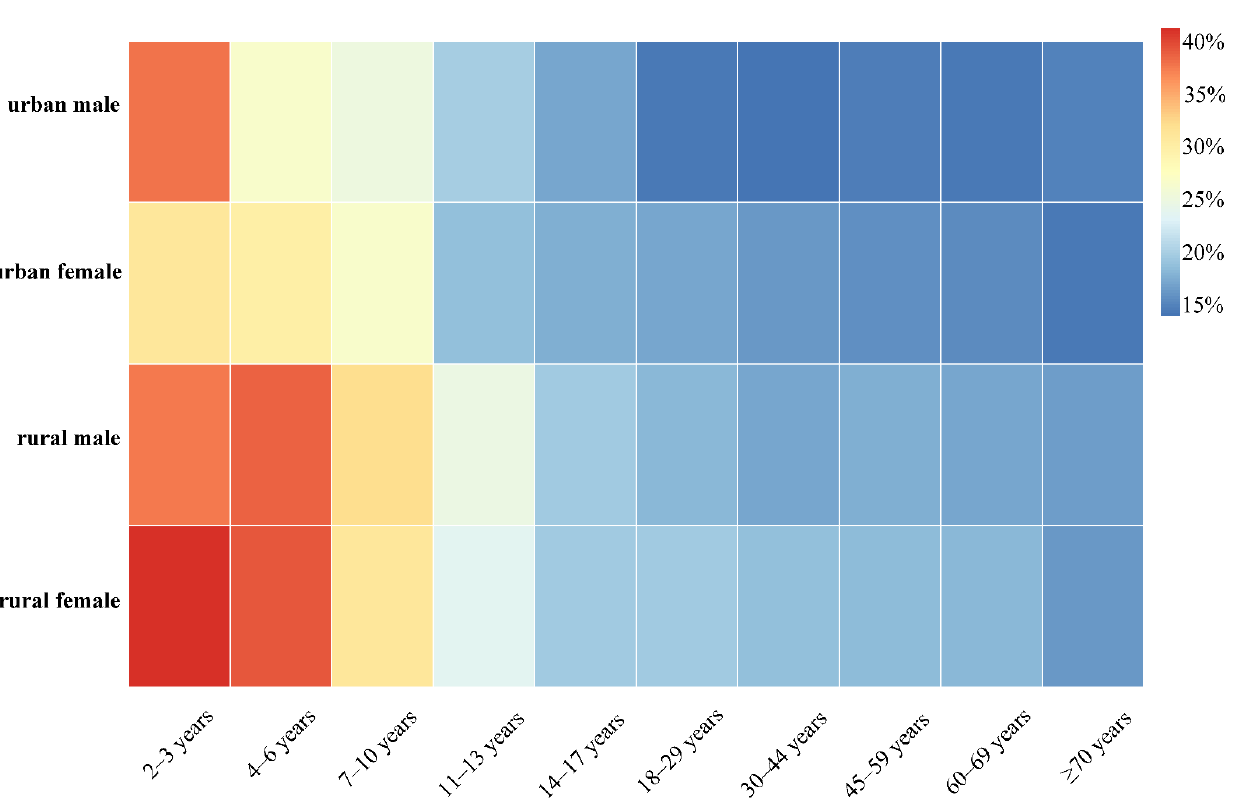
Figure 3. Heatmap of cumulative dietary exposure risk outcomes for different consumer groups (upper 95% confidence interval at P97.5 level).